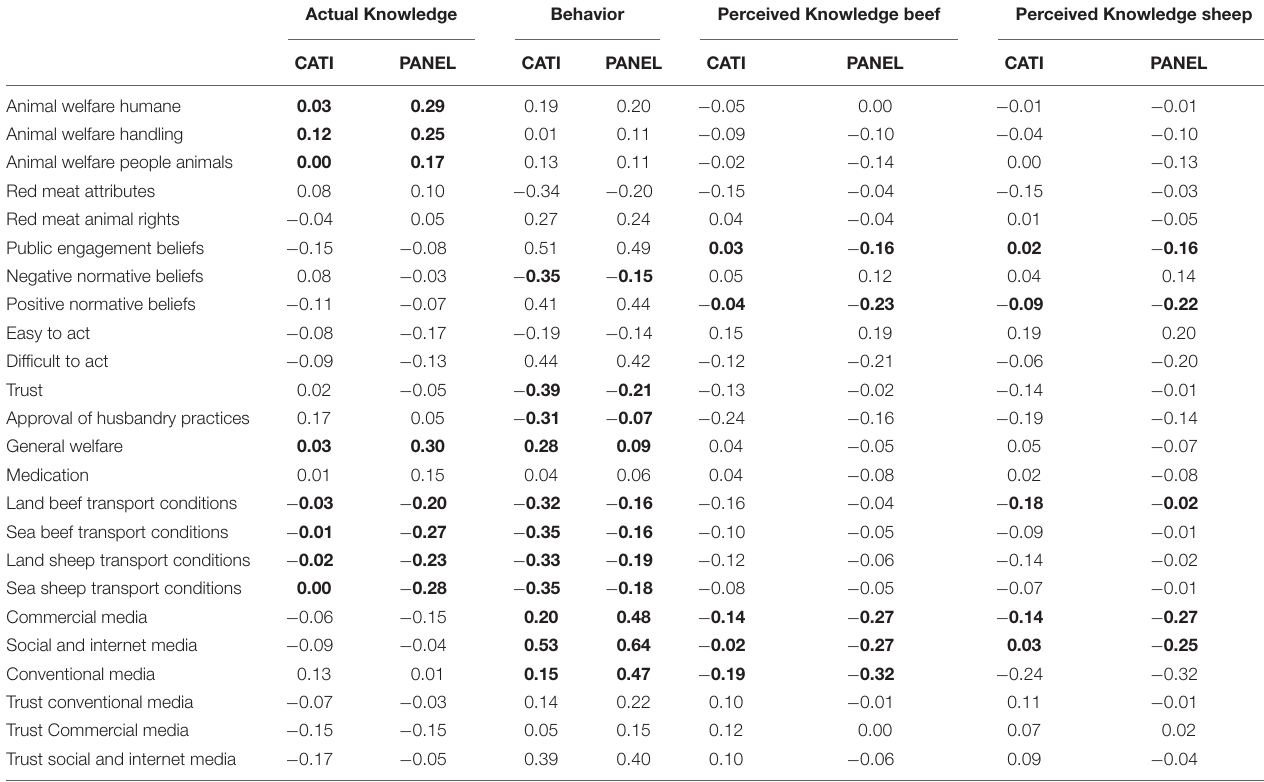
TABLE 7 | Correlations (df = 1030) between Knowledge, Community behavior and all composite variables.